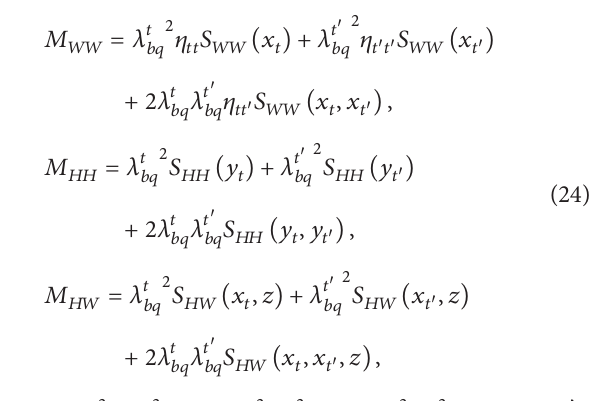
Figure 8: The “ 3 + 1 ” scenario, 𝑉 𝑡 󸀠 𝑏 = 0.001 ( |𝜆 𝑡 𝐵 → 𝑋 𝛾 and 𝐵 − 𝐵 𝑠 𝑞 𝑞 mixing, in the 4G2HDMI (a), the 4G2HDMII (b), and the 4G2HDMIII (c), for = 𝑚 /𝑚 𝜖 = 0.34(∼ 𝑚 /𝑚 ) . Figure taken from [61]. 𝜖 𝑏 𝑏 𝑏 󸀠 , and 𝑡 𝑡 𝑡 󸀠